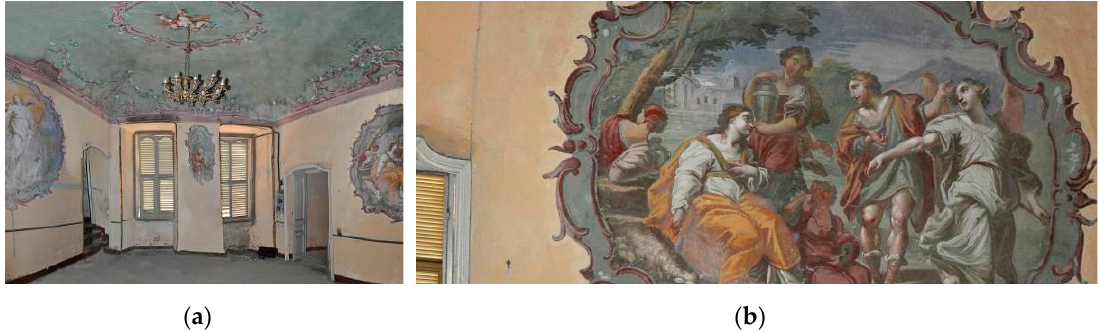
Figure 7. ( a ) Second room with frescoed vault and wall medallion. ( b ) Detail of the fresco depicting the wedding of Tobia with Sara.